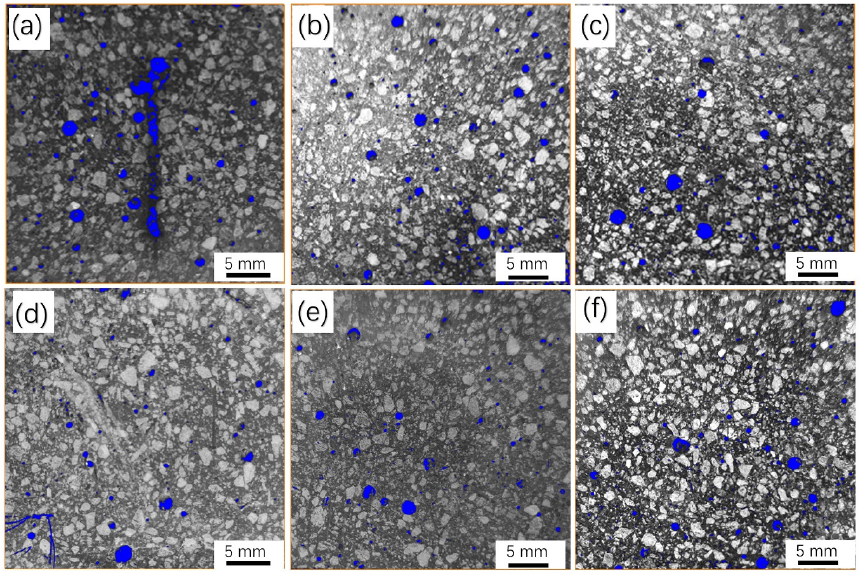
Figure 10. Macrostructure of straight BCSF-reinforced UHPC with varying content of 1–6 wt.% cured for 28 days: ( a ) 1%; ( b ) 2%; ( c ) 3%; ( d ) 4%; ( e ) 5%; ( f ) 6%. Table 3. porosity of straight BCSF-reinforced UHPC mixtures with 1–6 wt.% cured for 28 days.